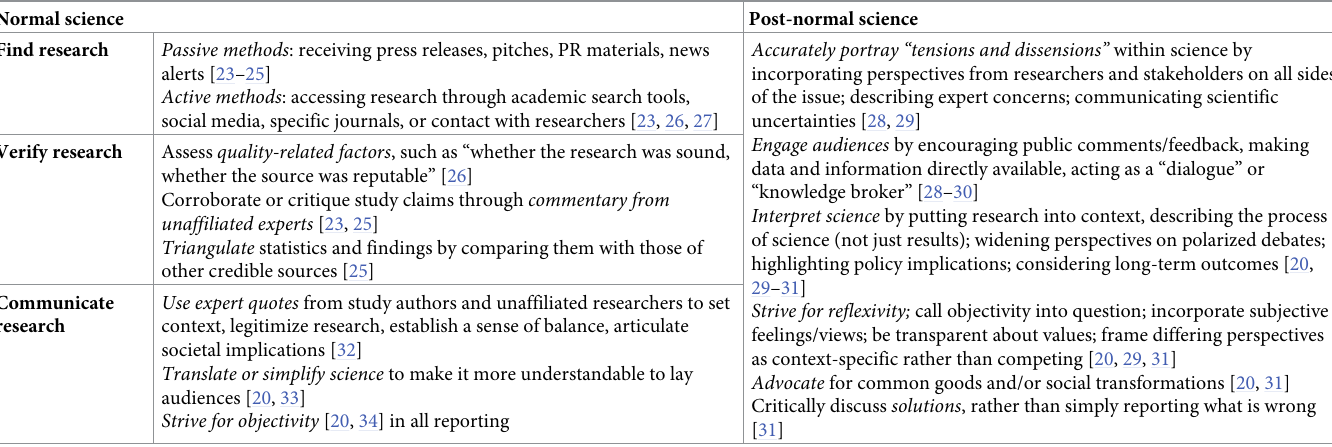
Table 1. Normal and post-normal science journalism practices described in previous